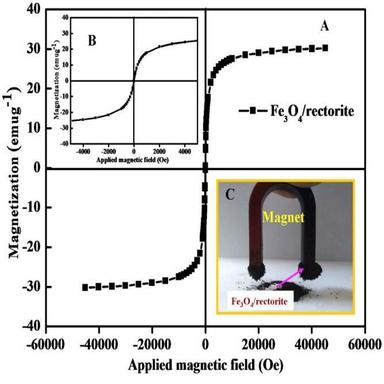
Magnetization curve of Fe3O4/rectorite.